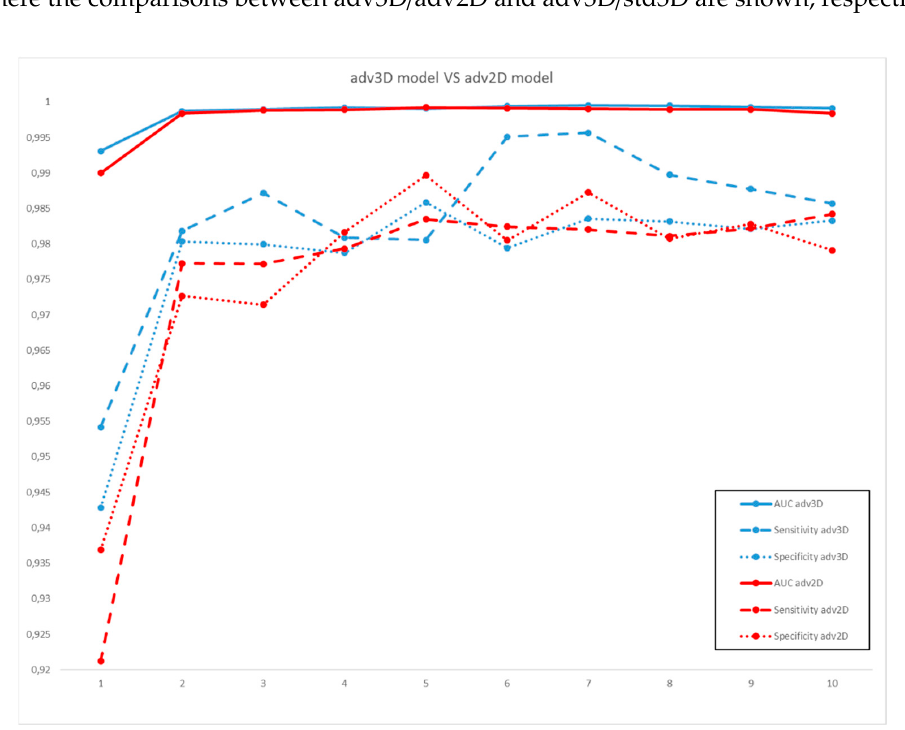
Figure 1. Area under the receiver operating characteristics curve (AUC) (full line), sensitivity (dashed line), and specificity (dotted line) of the multivariable models for adv3D (in blue) and adv2D (in red), for model orders from 1 to 10.